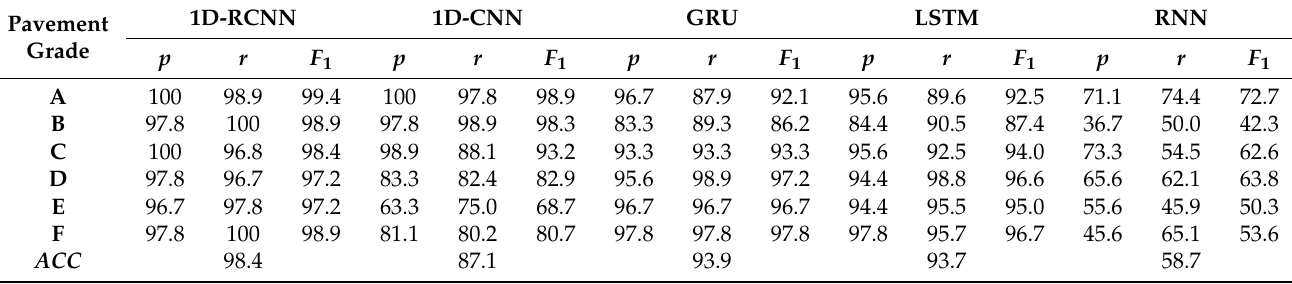
Table 4. Test results of five typical deep learning classification models (unit: